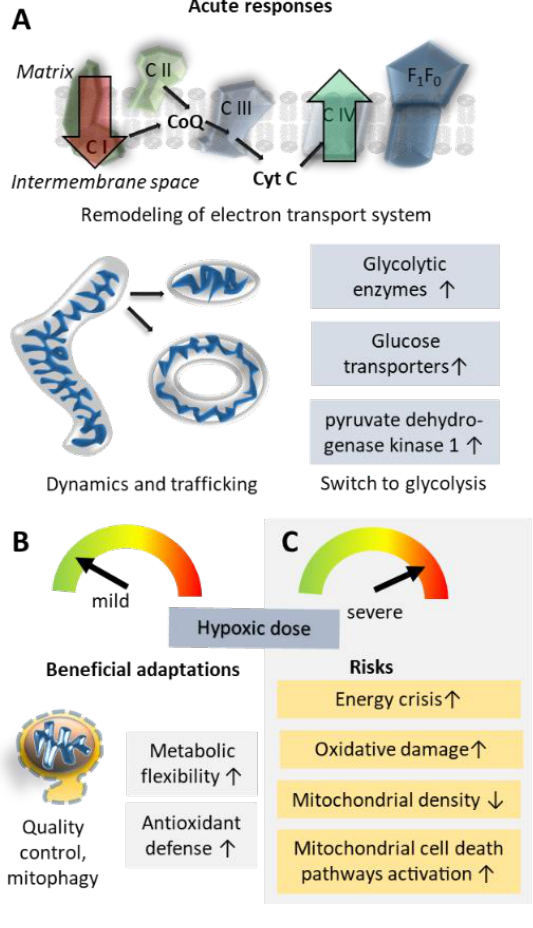
Figure 3. Mitochondrial responses to hypoxic stress. Acute responses of mitochondria to hypoxia ( A ) that lead to beneficial ( B ) or detrimental ( C ) outcomes, depending on the hypoxic dose and cellular resilience. CI — CIV, mitochondrial respiratory complexes I — IV; CoQ, coenzyme Q; Cyt C; cytochrome C; F 1 F 0 , F 1 F 0 ATP synthase.